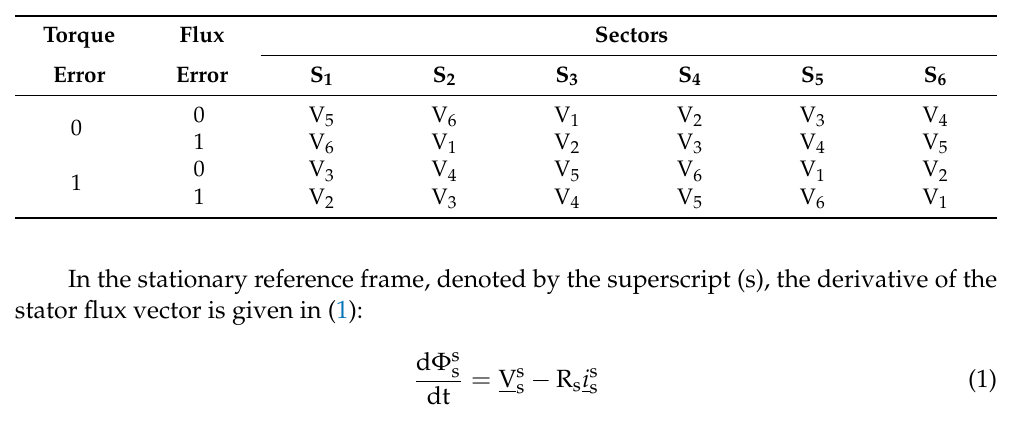
Table 1. The switching table for the classical